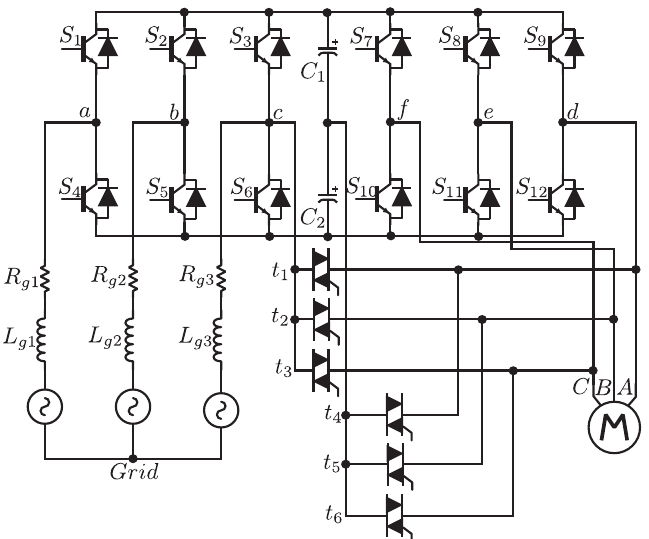
Figure 11. Fault-tolerant back-to-back converter. The t 1 , t 2 , or t 3 TRIACs can replace any inverter-side faulty leg and be reconfigured to a four-leg converter by connecting the midpoint of the capacitors (using t 4 , t 5 , or t 6